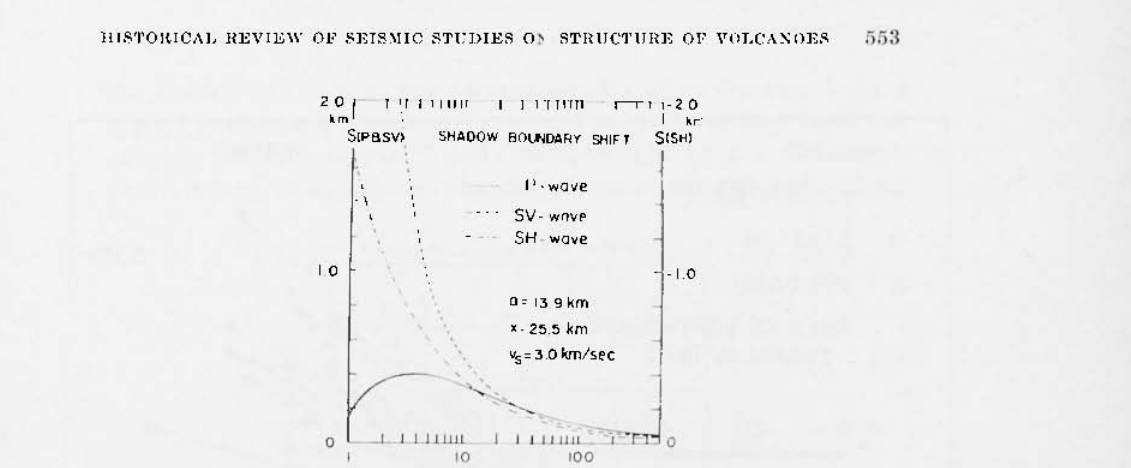
Fig-. 27. - J)CllC[J(\{'nee on (n'ljueney o( tile efTed.iyc .~In!(low hOll[J(lar.y shift. for wayes (liffrade(l fl'Olll an hollow